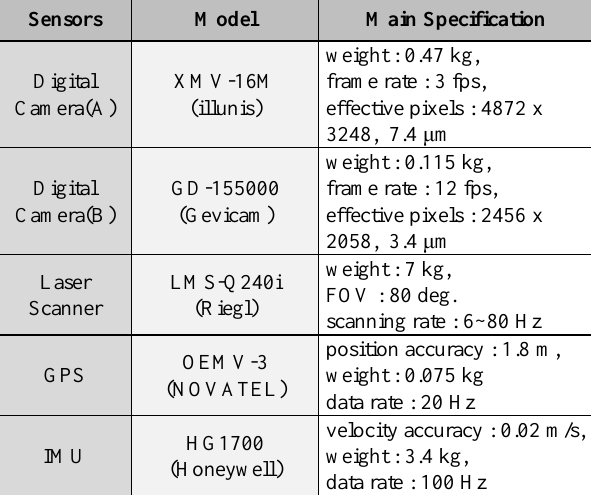
Figure 5. Deployable ground station